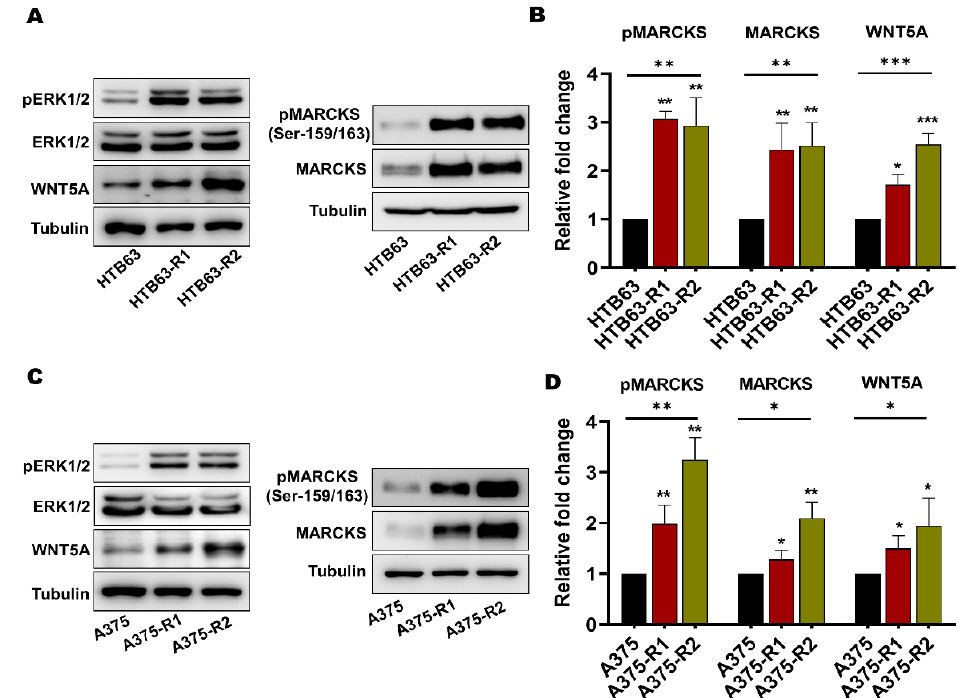
Figure 2. Acquired BRAFi resistance in melanoma cells causes significant increases in the levels of total MARCKS and active phospho-MARCKS. ( A ) Western blot analysis showing the endogenous levels of phospho-ERK1/2 (pERK1/2), total ERK1/2, WNT5A, phospho-MARCKS (pMARCKS; Ser-159/163), and total MARCKS in BRAFi-sensitive and BRAFi-R HTB63 cells. Tubulin was used as the loading control. Representative blots from 4 independent experiments are shown. ( B ) Graph showing the densitometric analysis of pMARCKS, total MARCKS, and WNT5A protein levels in BRAFi-sensitive and BRAFi-R HTB63 cells. The obtained values were normalized to the value of the tubulin loading control from the same sample. The calculated pMARCKS/tubulin, MARCKS/tubulin, and WNT5A/tubulin ratios were normalized to those in the BRAFi-sensitive HTB63 cells and are presented as relative fold changes. ( C ) Western blot analysis showing the endogenous levels of pERK1/2, total ERK1/2, WNT5A, pMARCKS (Ser-159/163) and total MARCKS in BRAFi-sensitive and BRAFi-R A375 cells. Tubulin was used as the loading control. Representative blots from 4 independent experiments are shown. ( D ) Graph showing the densitometric analysis of